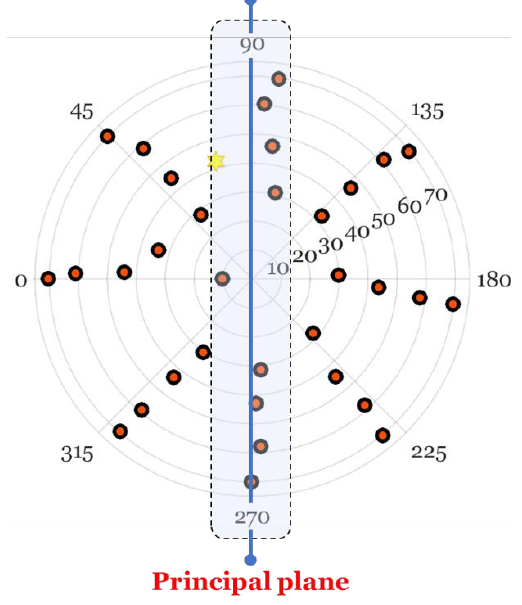
Figure 4 . A top view of all estimated camera locations as obtained through SFM. The numbers 0 to 315 on the circumferential circle and 10 to 70 between the various circles indicate azimuth and zenith angles in degrees, respectively. We consider the locations within the rectangular area as approximately placed within the principal